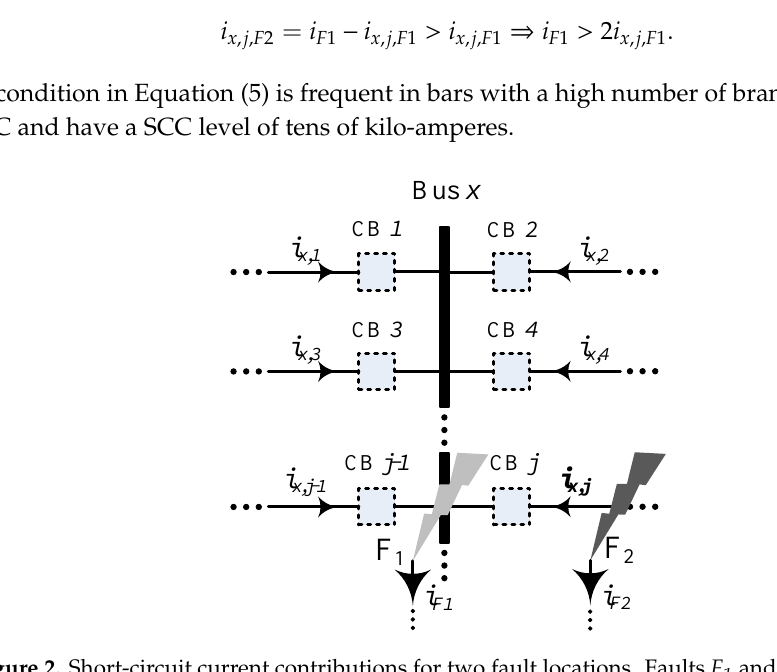
Figure 2. Short-circuit current contributions for two fault locations. Faults F 1 and F 2 , in phase x . Therefore, simultaneous overcurrents could exceed the capacity of several CBs of the same